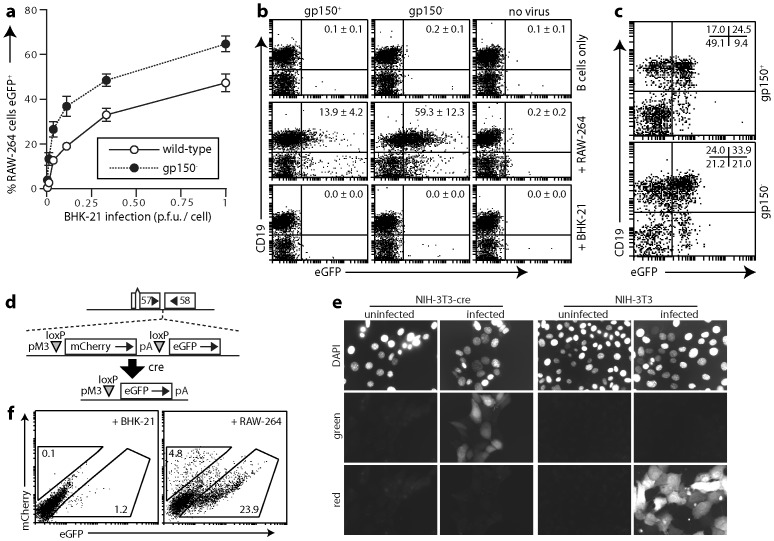
Infection by co-culture.
a. BHK-21 cells were infected with gp150+ or gp150− EF1α-eGFP MuHV-4 at different multiplicities (2 h, 37°C), then washed ×3 in PBS and cultured overnight with an equal number of RAW-264 cells. 18 h later RAW-264 cells (CD11b+) eGFP expression was assayed by flow cytometry. Each point shows the mean ± SD of 3 replicate cultures. Equivalent data were obtained in 3 experiments. b. Gp150+ or gp150− EF1α-eGFP MuHV-4 (106 p.f.u.) was added to 3×105 RAW-264 cells or BHK-21 cells. 18 h later 106 spleen cells were added to these cultures. As a control, a further 106 spleen B cells were exposed directly to 106 p.f.u. of virus. 24 h later eGFP expression in B cells (CD19+) was assayed by flow cytometry. The numbers show mean ± SD %eGFP+ of total CD19+ cells in 5 experiments. All BHK-21 cells and most RAW-264 cells were excluded from the flow cytometric analysis by FSC/SSC gating. The CD19−eGFP+ cells in RAW-264 cell co-cultures correspond to residual infected RAW-264 cells. The splenocytes included very few myeloid cells (<1% CD11bhi or CD11c+). c. Gp150+ or gp150− EF1α-eGFP MuHV-4 (106 p.f.u.) was added to 106 peritoneal macrophages. 3 days later, to allow for the limited lytic infection of these cells, we added 106 spleen cells. 18 h later eGFP expression in B cells (CD19+) was assayed by flow cytometry. The numbers show the % cells in each quadrant. All CD19−eGFP+ cells were CD11bhi macrophages. Again control BHK-21 cell co-cultures gave <0.5% eGFP+ B cells. Equivalent data were obtained in 3 experiments. d. A MuHV-4 recombinant (MHV-RG) was generated in which a viral M3 promoter (pM3) drives mCherry expression from the ORF57/ORF58 intergenic site. LoxP recombination by cre excises mCherry plus its polyadenylation signal to release eGFP expression from the same promoter. e. Cre+ or control cre− NIH-3T3 cells were infected or not with MHV-RG (0.5 p.f.u./cell) and 18 h later imaged for red (mCherry) and green (eGFP) fluorescence. Nuclei were counterstained with DAPI. f. BHK-21 cells or RAW-264 cells were infected with MHV-RG (1 p.f.u./cell, 18 h) then co-cultured with cre+ NS0 cells. After 3 days the NS0 cells (MHC class IIhi) were analysed for green and red fluorescence by flow cytometry. The percentage of total cells in each gate is indicated. Equivalent data were obtained in a repeat experiment.